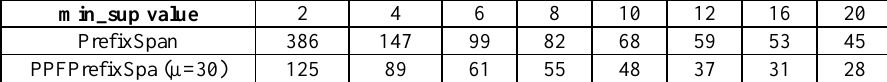
Table 1. Execution efficiency comparison results.